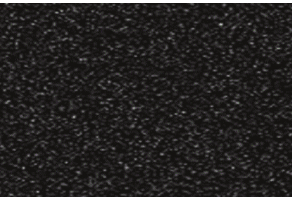
Figure 10: The encrypted image using the encryption method in fractional-order Chua system (1) as in Section 2.